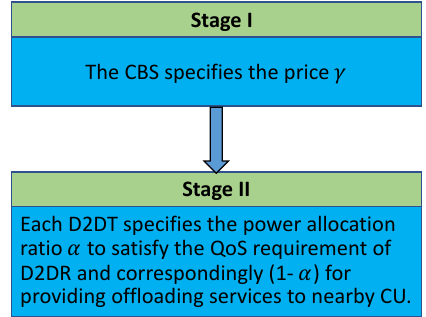
Figure 2. Stackelberg game for the proposed price model. D2DT, D2D transmitter; D2DR, D2D